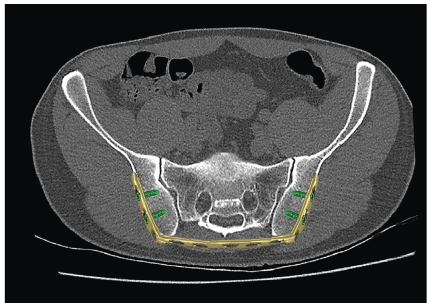
Figure 4: Schematic representation of the